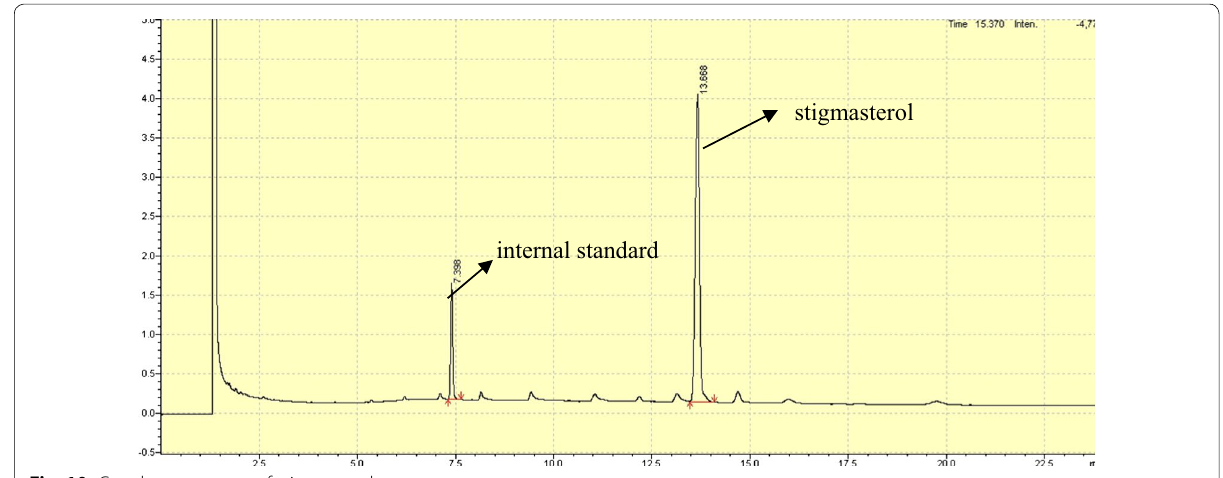
Fig. 10 Gas chromatogram of